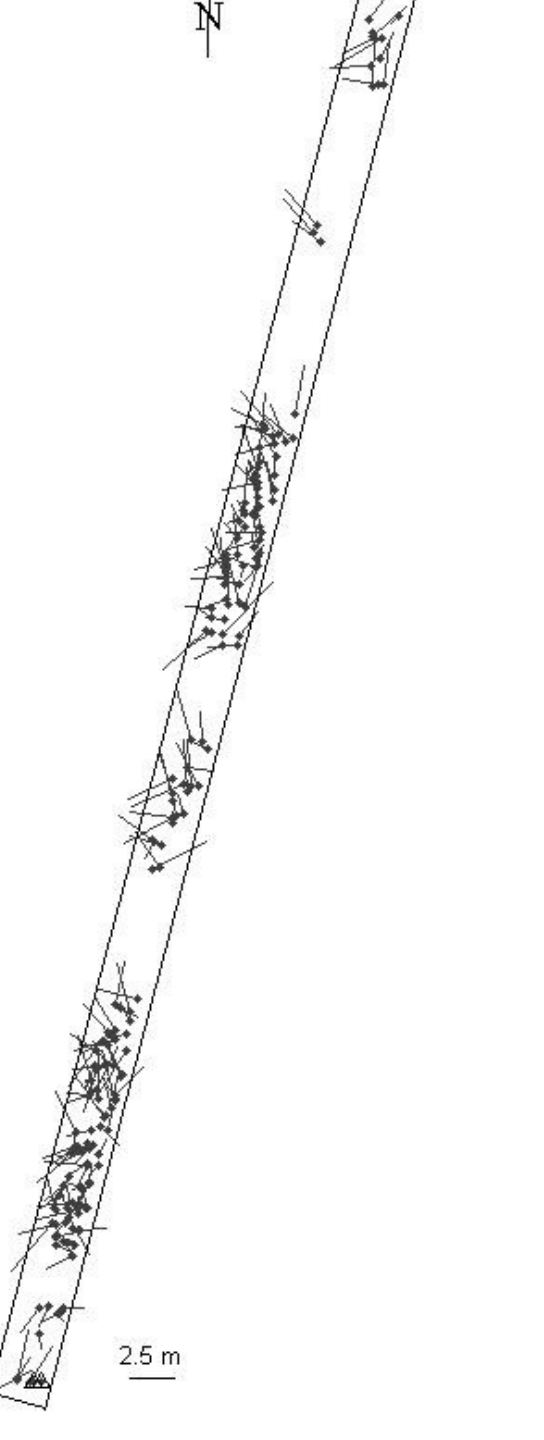
Figure 3. 55-scene, 1527km-long PRISM strip showing 4 GCPs (triangles) and discrepancy vectors in planimetry at 194 check